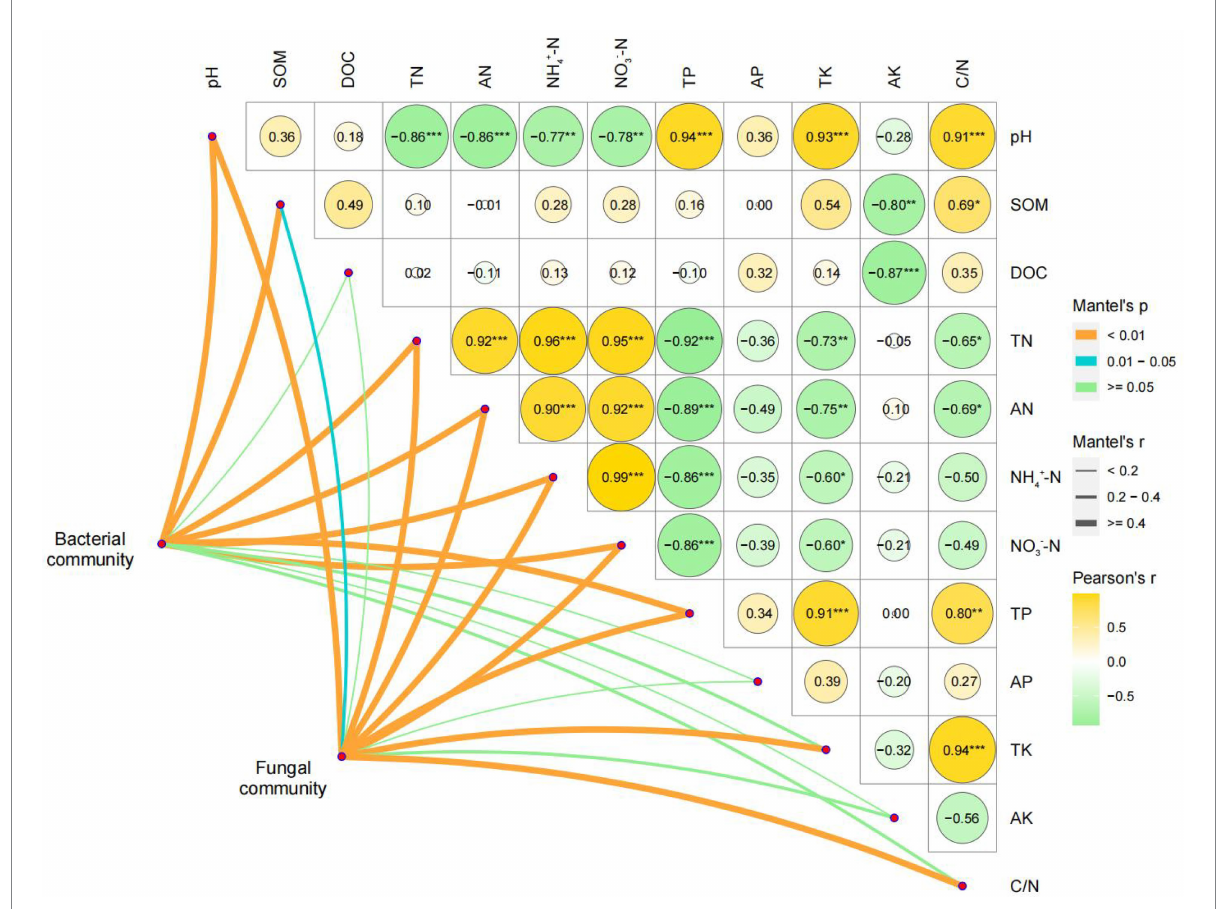
FIGURE 5 Mantel test analysis based on the relative abundance matrix of the genera with LDA value >2.0. SOM, soil organic matter; DOC, dissolved organic C; TN, total N; AN, alkali-hydrolyzed N; NH 4+ –N, ammonium N; NO 3− –N, nitrate N; TP, total P; AP, available P; TK, total K; AK, available K; C/N, ratio of C and